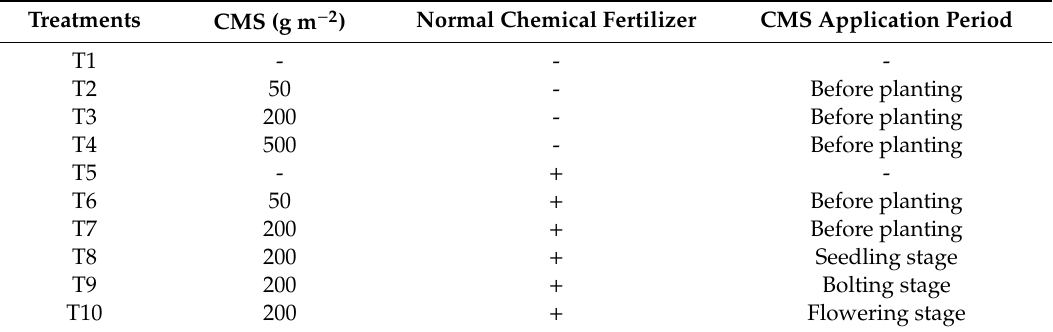
Table 2. Nutrient application amount for the field trial of Brassica napus during the growth season. Treatments